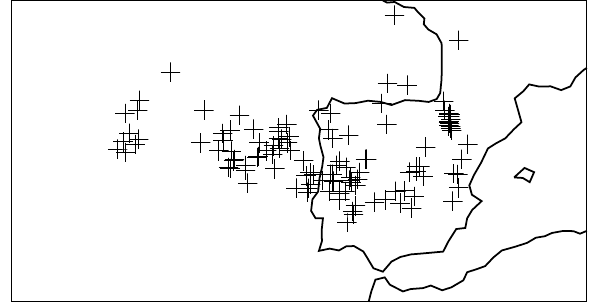
Fig. 12. Crosses indicate where the rays reached the ground